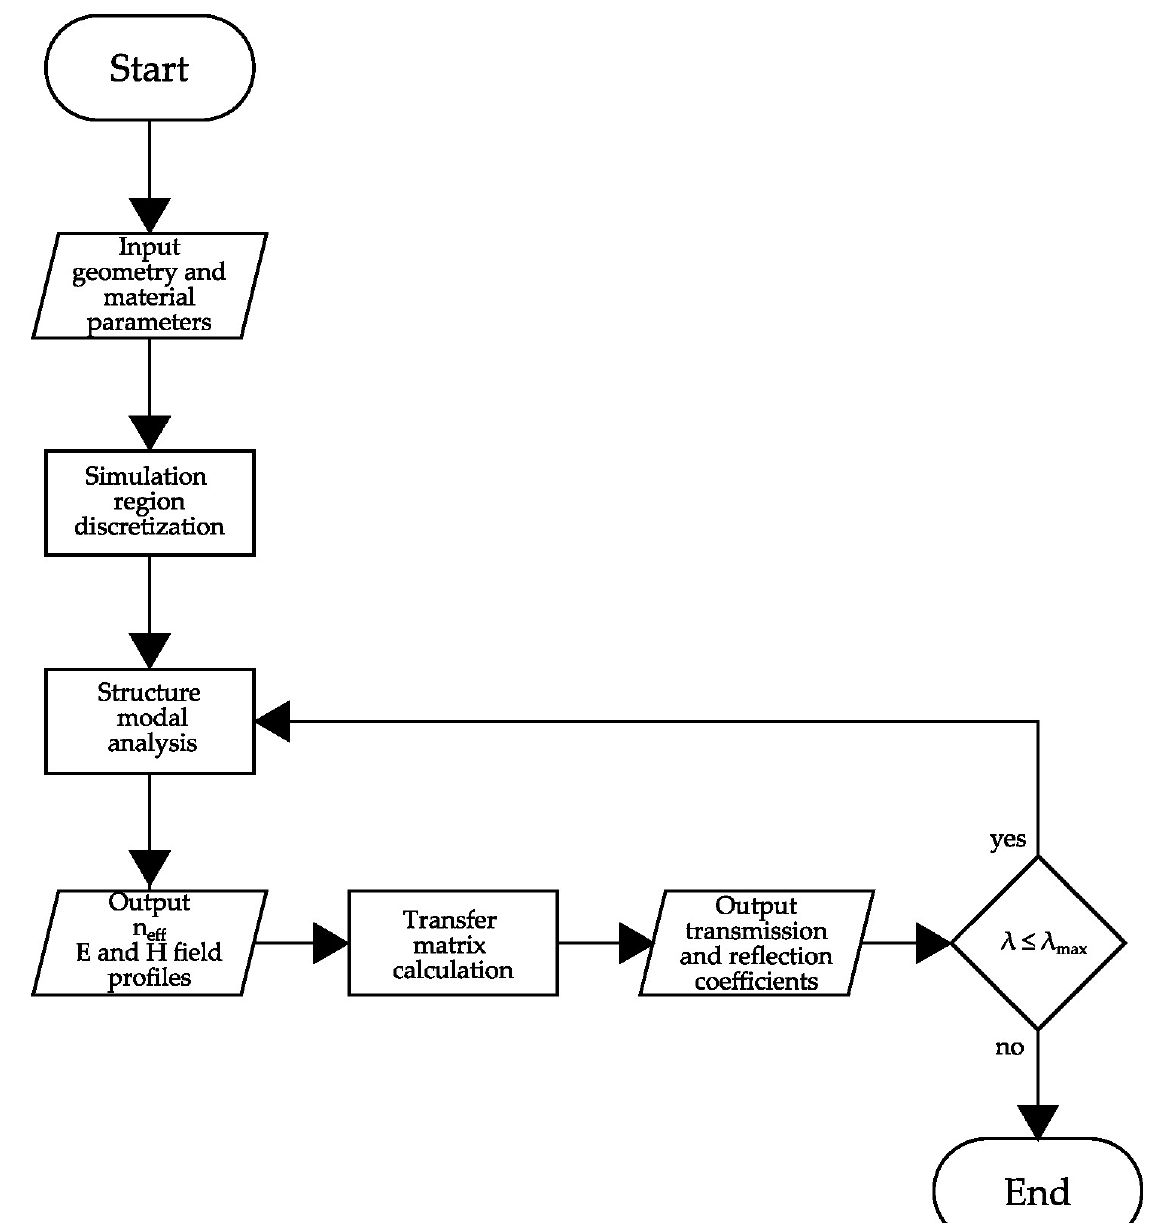
Figure 2. Flowchart to obtain the device parameters.